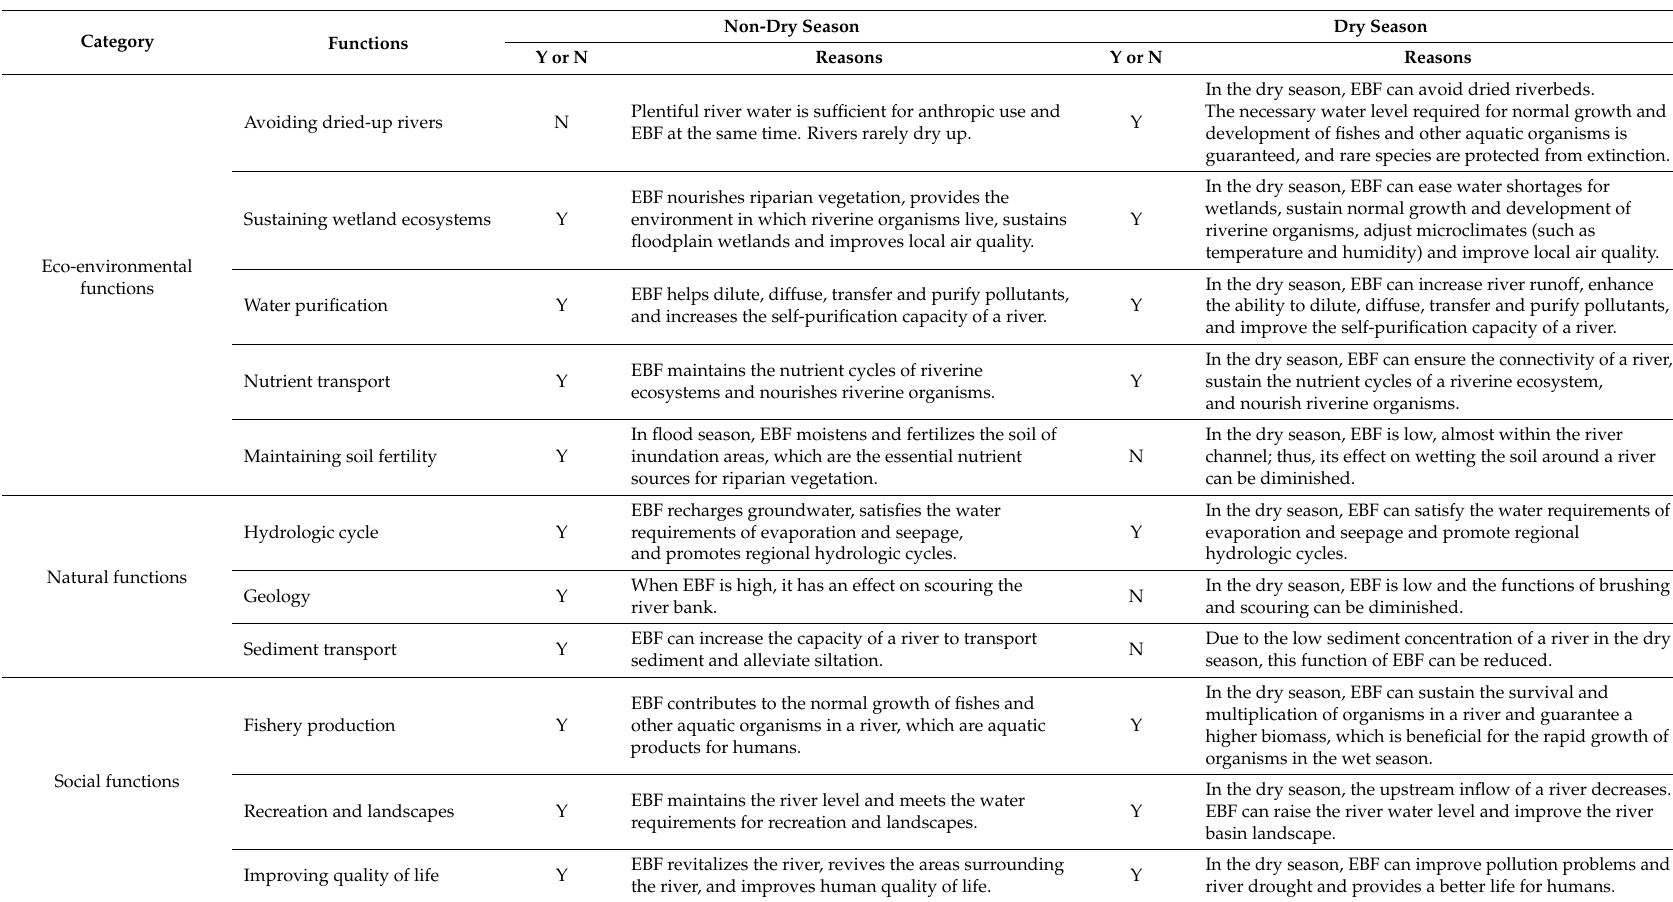
Table 1. Different functions of environmental base flow (EBF) between the dry season and non-dry season. “Y” represents the possession of this function; “N” represents the absence of this